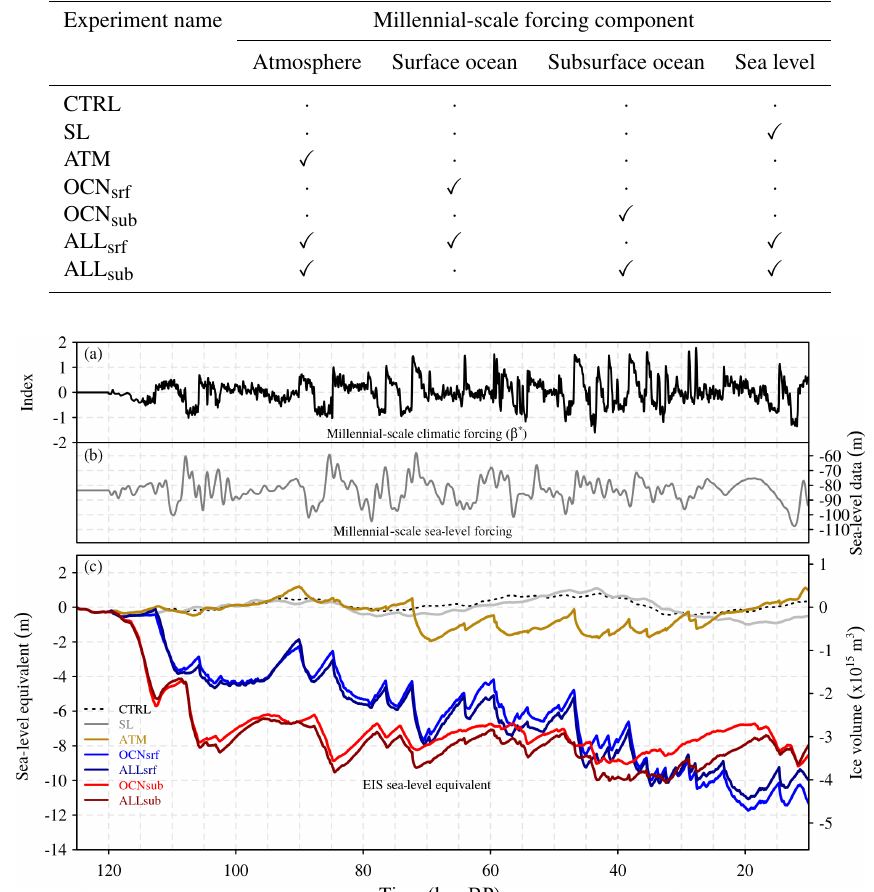
Figure 4. (a) Temporal component of the millennial-scale climatic forcing ( β (cid:63) index). (b) Millennial-scale sea-level forcing (Grant et al., 2012). (c) EIS sea-level equivalent (in meters) related to ice volume variations (in cubic meters) with respect to initial conditions for the CTRL run (black) and for the SL (gray), ATM (gold), OCN srf (blue), OCN sub (red), ALL srf (dark blue) and ALL sub (dark red) forcing